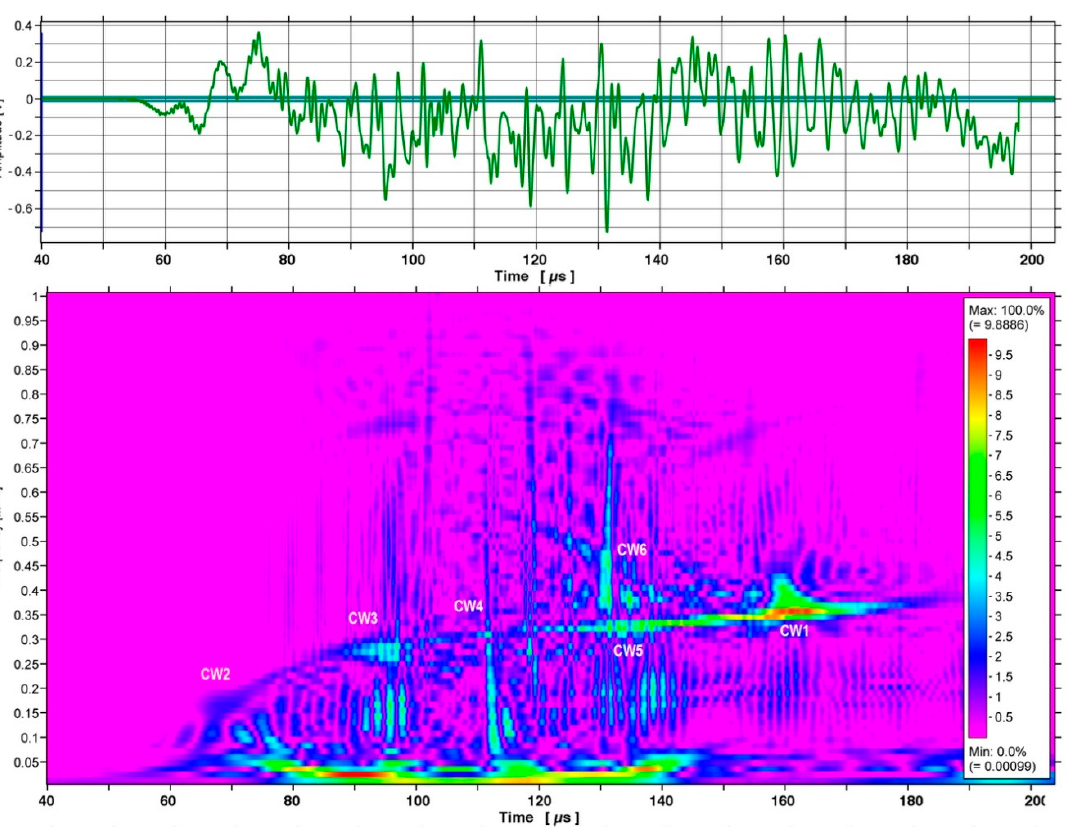
Figure 6. Output waveform of a KRN sensor (#11063) and its CWT spectrogram for 40–200 µs segment up to 1 MHz. Some peak positions are marked as cw1 to cw6, which correspond to those in Figure 4.